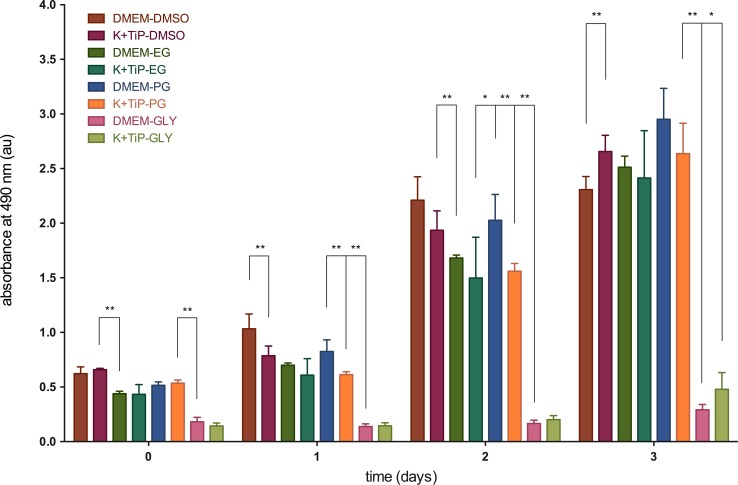
Viable cells in proliferation after use of slow freezing methods.The CellTiter 96® AQueous One Solution Cell Proliferation Assay (COS, Promega Corporation, Mannheim, Germany) was used to determine viable cells in proliferation at one hour after thawing and at day one, two, and three. Figure 2 illustrates the absorption of viable cells in proliferation after the use of slow freezing methods. DMEM = DMEM Ham’s F-12 Gln+, 20% FBS, and 1.5M of one of the CPAs; K+TiP = K+TiP. 0.5M sucrose, 20% FBS, and 1.5M of one of the CPAs; DMSO = dimethyl sulfoxide; EG = ethylene glycol; PG = propylene glycol; GLY = glycerin; * = significant (p < 0.05); ** = medium significant (p < 0.01); au = absorbance units.